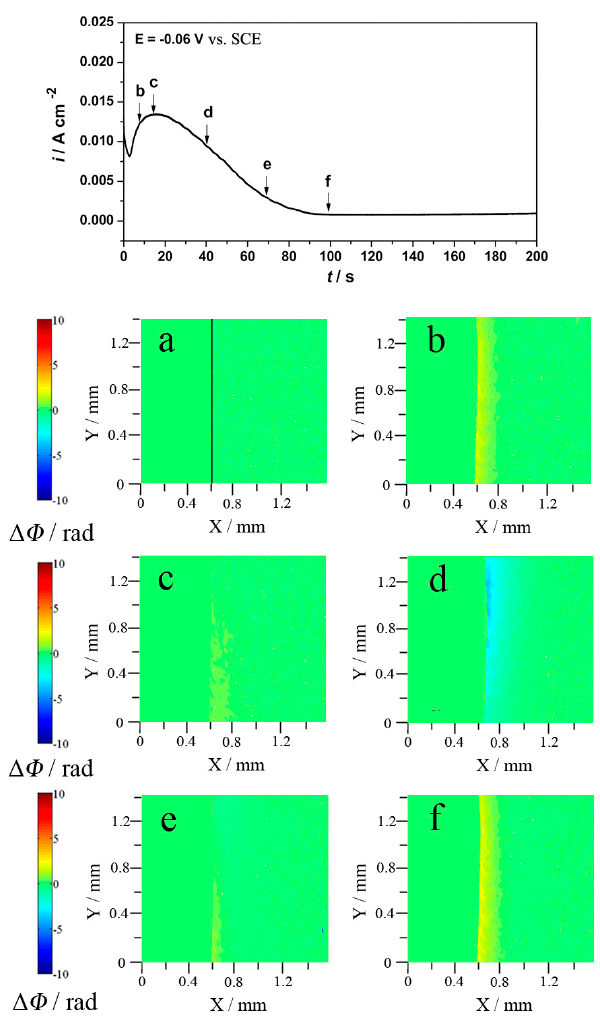
Figure 6. The i-t curve of Cu / NaCl system at − 60 mV vs. SCE (Top). ( a ) was obtained at the open circuit potential (OCP). ( b–f ) are the phase maps corresponding to the points b–f in the curve.